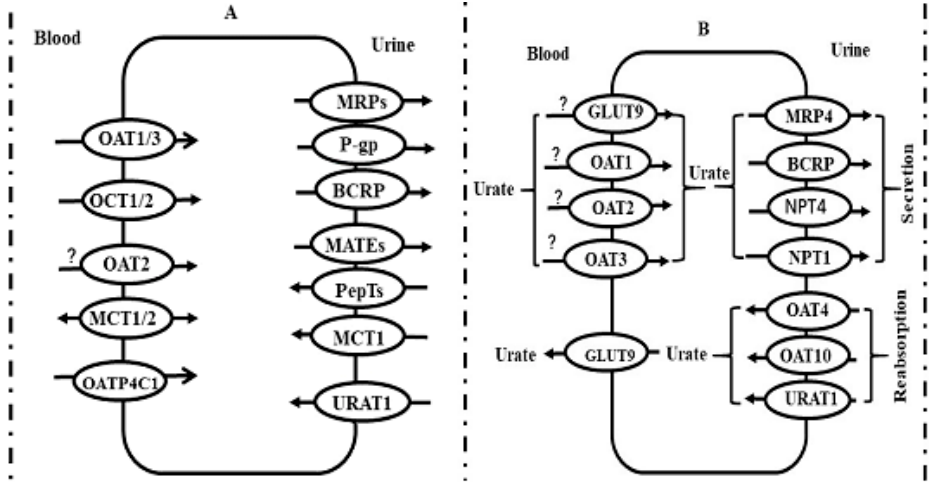
Figure 3. ( A ) Possible location of main transporters in human kidney and ( B ) roles of transporter interplay in renal excretion of uric acid . Symbol : OATPs, organic anion transporting